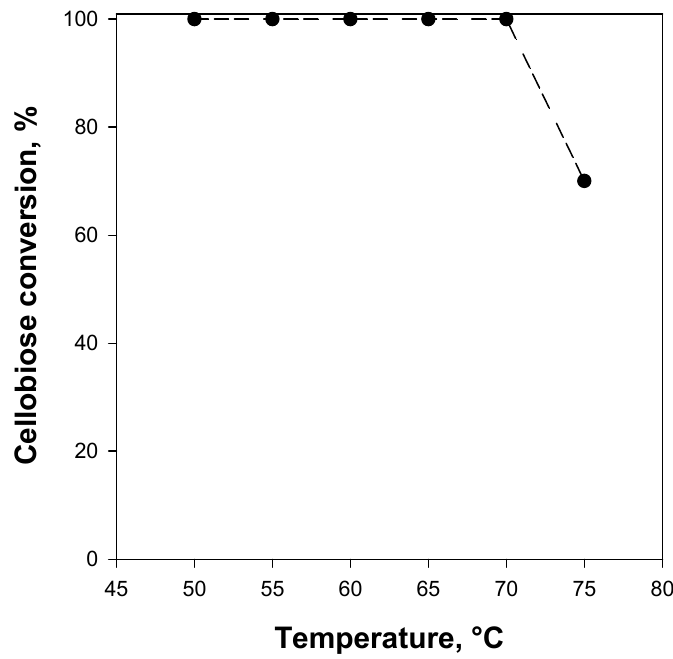
Figure 6. Cellobiose conversion to glucose as a function of the reaction temperature over WSN monolith catalysts. Batch-equivalent contact time: 2 h.